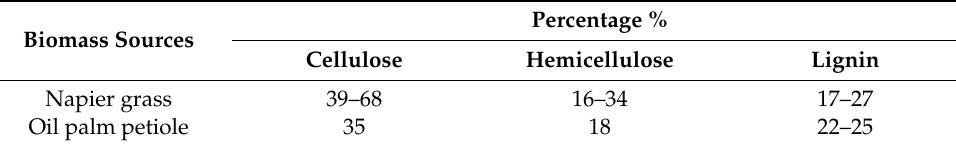
Table 1. Composition of Napier grass and oil palm petiole.